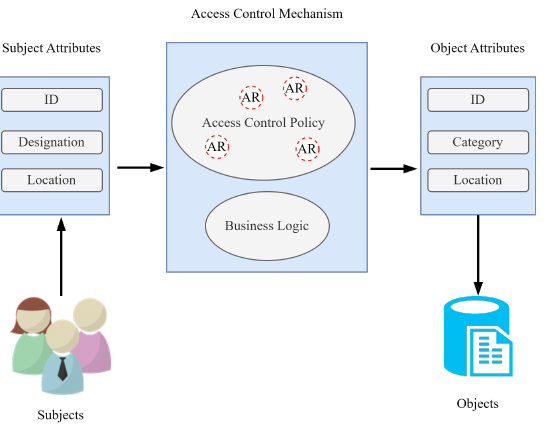
Figure 4. A naive architectural representation of attribute-based access control system consisting of groups of objects and subjects with